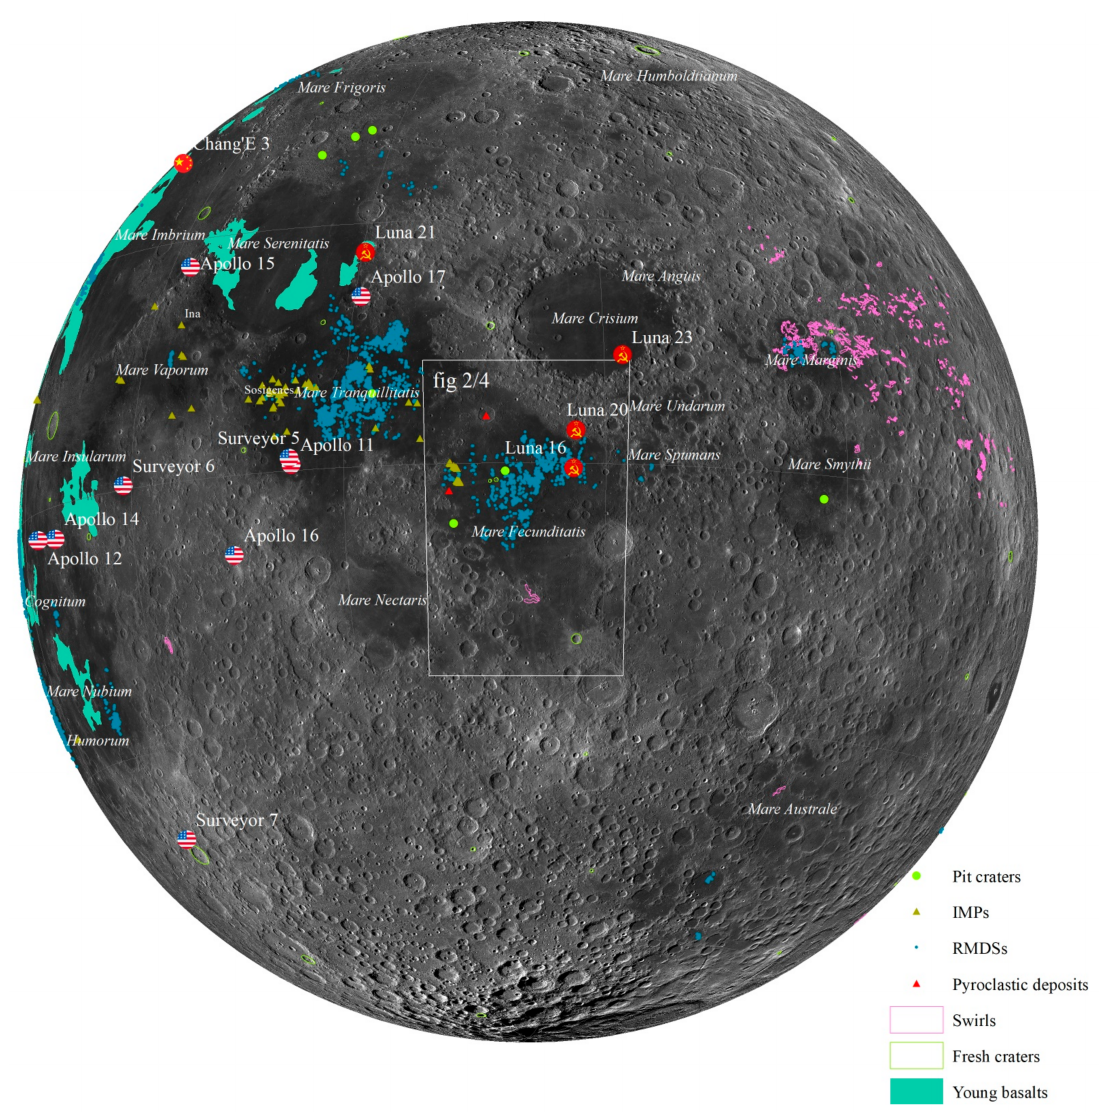
Figure 1. Orthographic map of Wide Angle Camera (WAC, [13]) image with projection center in Mare Fecunditatis (7.8 ◦ S, 53.7 ◦ E). The flag icons stand for the previous soft-landing missions of the United States, Soviet Union, and China, respectively. The green points, dark yellow triangles, blue points, red triangles, pink outlines, green outlines, and jadeite areas represent identified pit craters [14], IMPs [15], RMDSs [16], pyroclastic deposits [17,18], swirls [19], fresh craters [20], and young basalts ( ≤ 3.0 Ga, [21–25]), respectively. The white box represents the locations of other figures in this